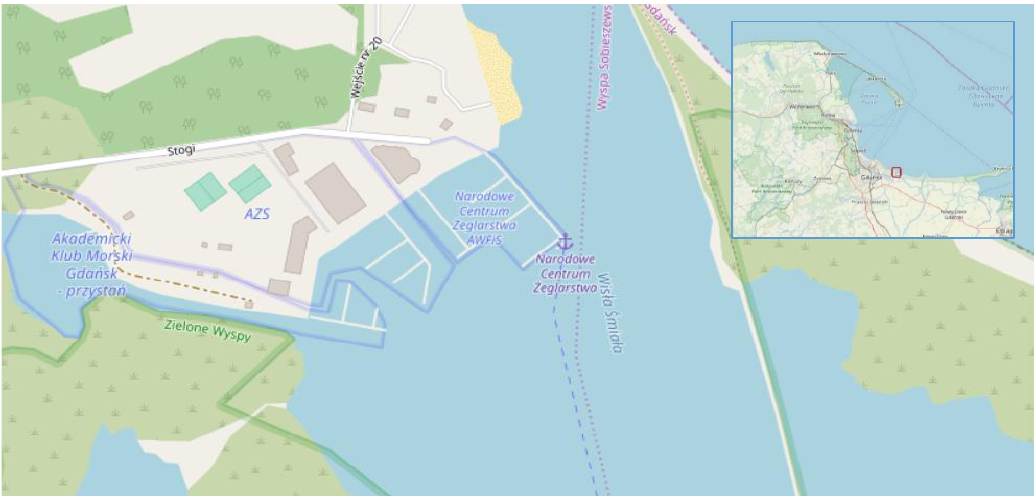
Figure 1. The area of the National Sailing Centre surrounded by neighbouring quay users.